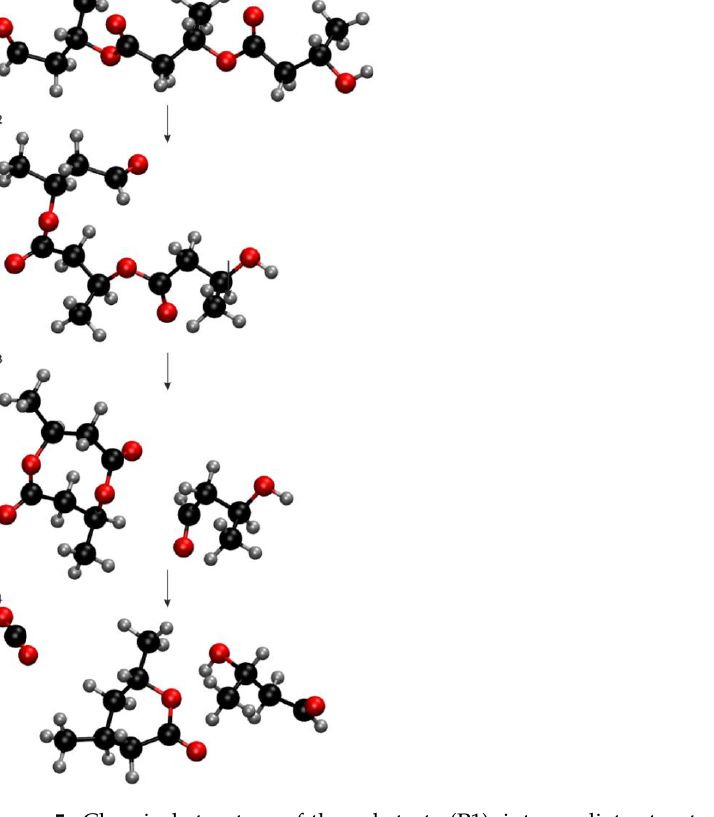
Figure 5. Chemical structure of the substrate (P1), intermediate structures (P2, P3) and the final product (P4) of the PHB thermal degradation process; the colors of the spheres are as follows: black — carbon, light grey — hydrogen, red — oxygen.